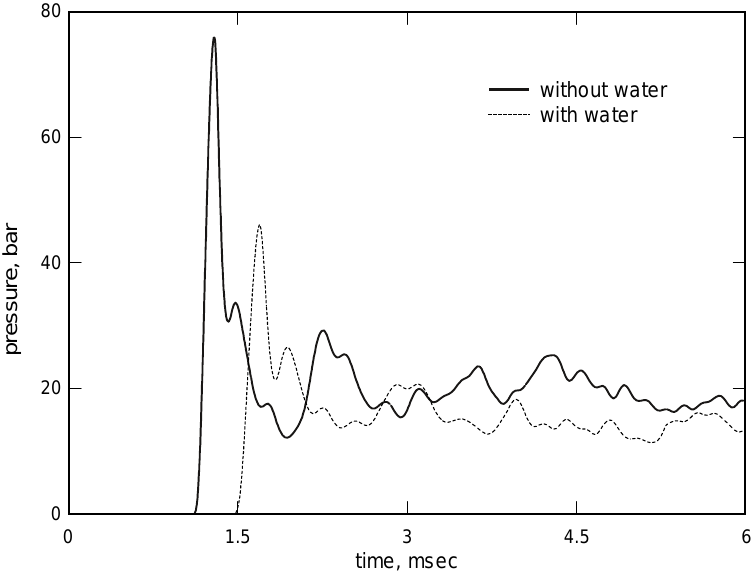
Fig. 6. Numerical simulation of pressure signatures at pressure point P1 in the tunnel